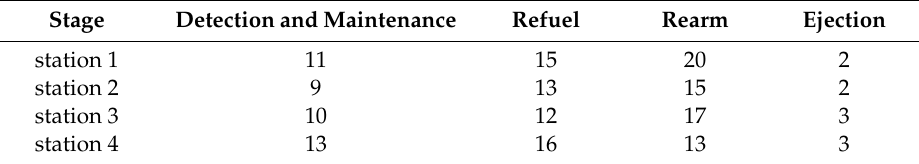
Table 4. The support time of each station for a similar carrier aircraft (minute).